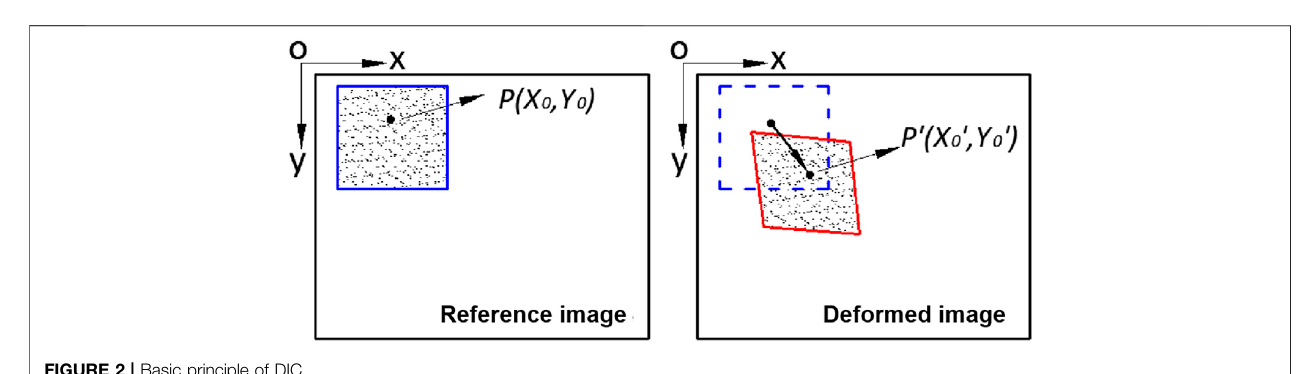
FIGURE 1 | Measurement system of uniaxial loading experiment.